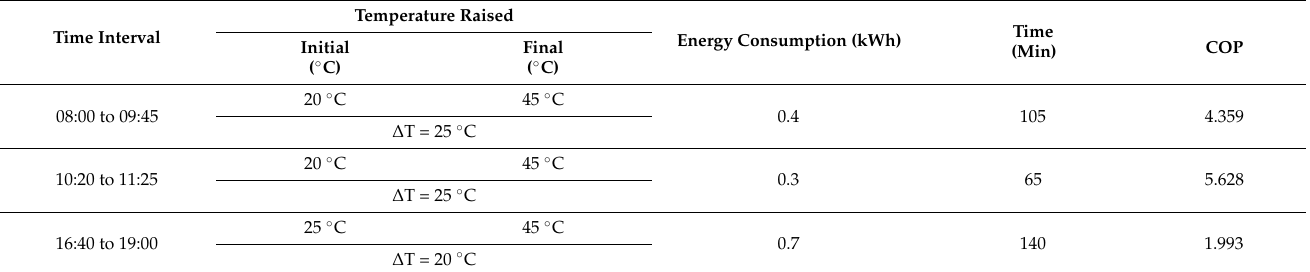
Table 3. Comparison of COPs at the different time